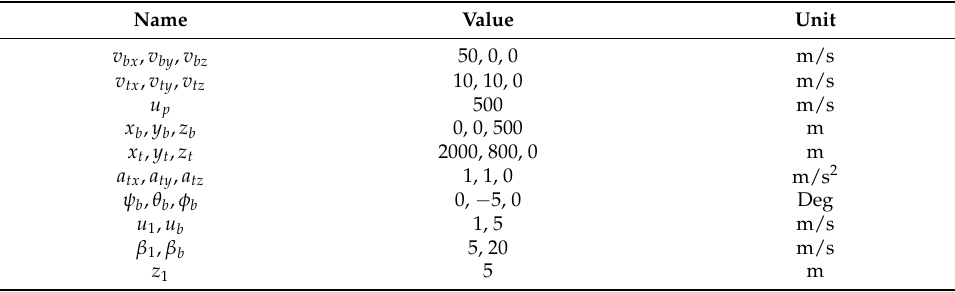
Figure 13. Miss distance in case 1. Table 4. The main parameters of the simulation case 1.